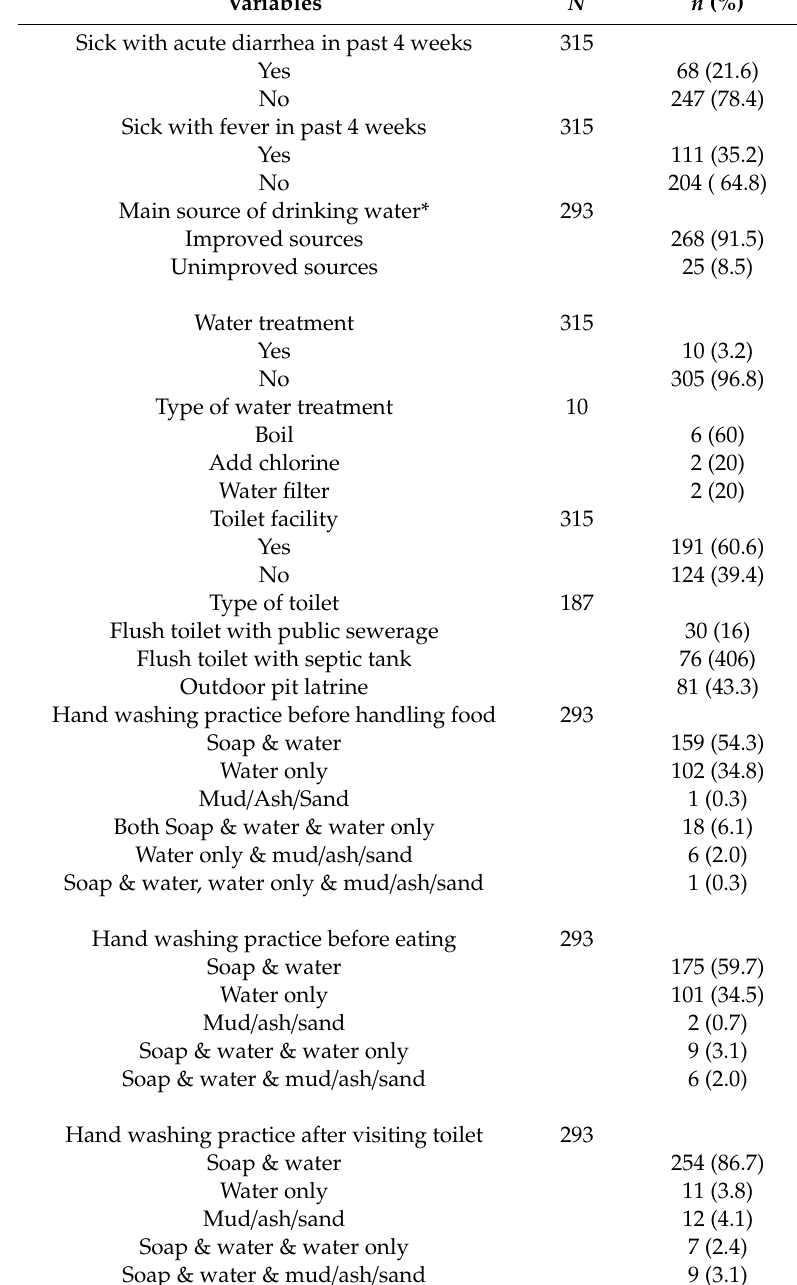
Table 2. Water, sanitation and hygiene characteristics ( N =